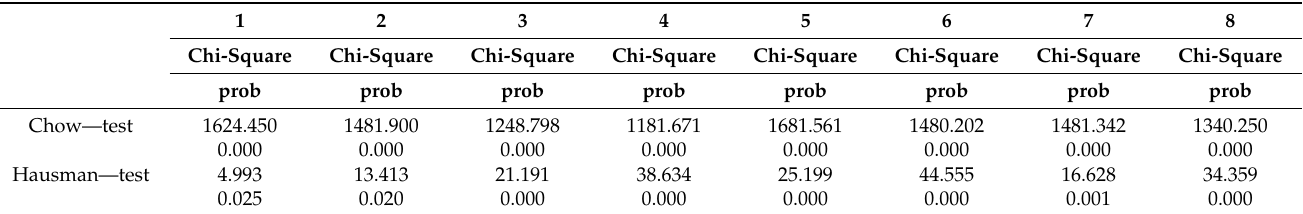
Table 7. Chow and Hausman